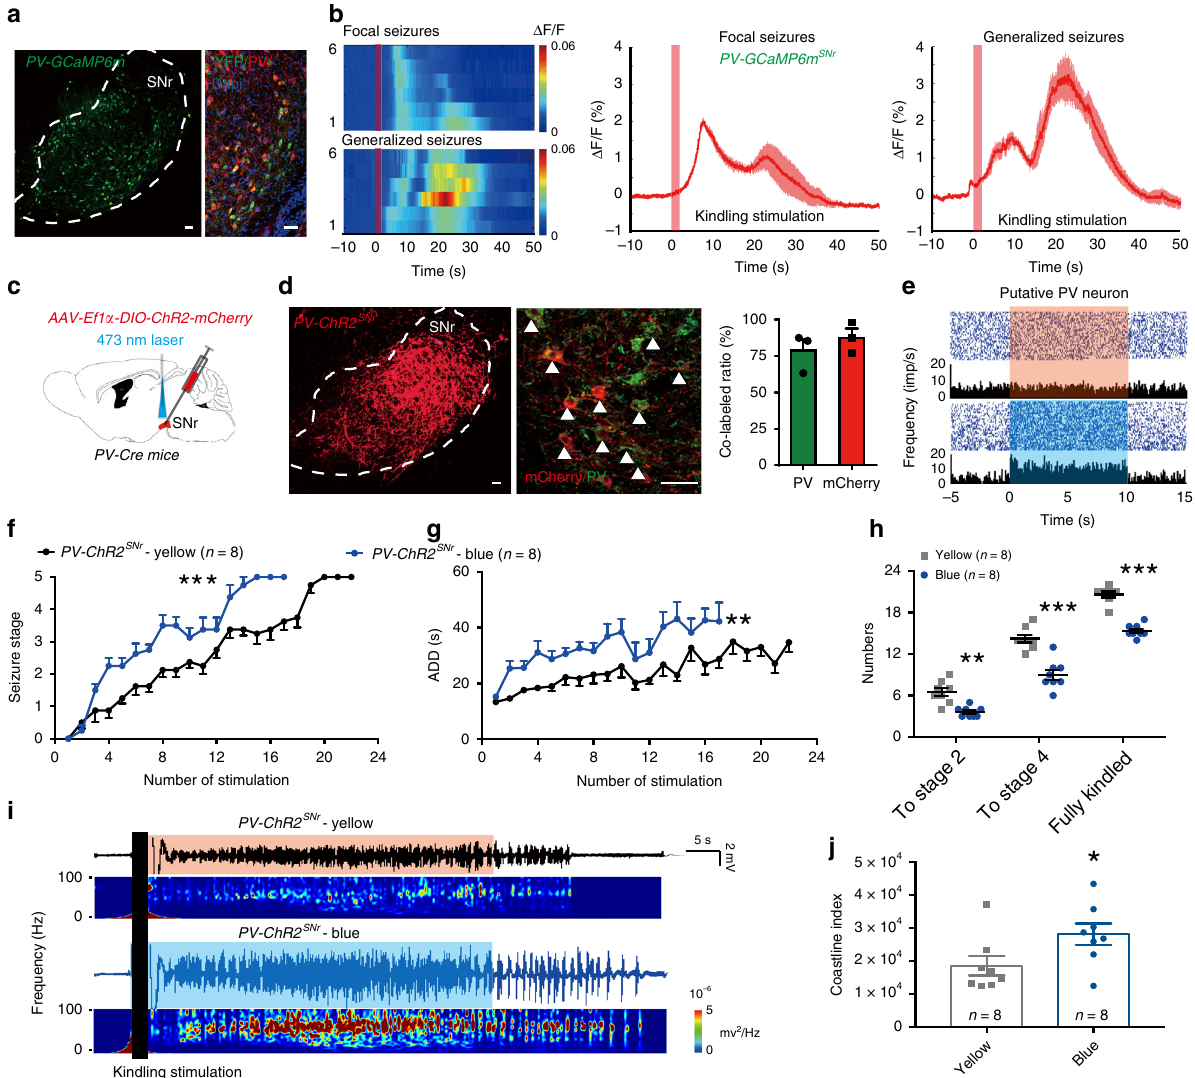
Fig. 1 Optogenetic activation of SNr PV neurons ampli fi es kindling progression in hippocampal kindling model. a Representative images of the SNr from a PV-GCaMP6m SNr mouse, showing the overlap of GCaMP6m- eYFP and PV-positive neurons. Scale bar, 50 μ m. b Fiber photometry of SNr PV neural dynamics during hippocampal kindling seizures in PV-GCaMP6m SNr mice. Left, heatmap illustration of calcium signals aligned to the initiation of kindling stimulation. Each row represents the typical calcium signal of each mouse during focal seizures and generalized seizures, and a total of six mice are illustrated. Color scale indicates Δ F / F and warmer colors indicated higher fl uorescence signal. Right, peri-event plots of the average calcium signals corresponding to the heatmaps. Thick lines indicated mean and shaded areas indicated SEM. The red rectangles represent kindling stimulation. c Scheme of experiment for viral injection and photostimulation in PV-ChR2 SNr mice. d Representative images of the SNr from a PV-ChR2 SNr mouse, showing the overlap in expression of ChR2-mCherry (red) and PV-positive neurons (green). Scale bar, 50 μ m. Right, quanti fi cation of the percentage of ChR2-mCherry neurons that co-expressed PV neurons from three PV-ChR2 SNr mice (repeated three times per mouse). e Representative peri-event raster histograms showing the fi ring rate of the same SNr PV neuron in response to blue-light and yellow-light stimulation. f – h Effects of optogenetic activation of SNr PV neurons on the development of seizure stage ( f ), afterdischarge duration (ADD, g ), and number of stimulations needed to reach each seizure stage ( h ) in the hippocampal kindling model. Align-and-rank data for a nonparametric ANOVA was used for f , general linear model with repeated measures was used for g , and Mann – Whitney U -test was used for h ; ** P < 0.01, *** P < 0.001 compared with yellow-light control. i , j Representative EEGs, corresponding EEG spectra power ( i ), and the quanti fi cation of EEG coastline index ( j ) recorded from the CA3 during the fully kindled state. The black rectangle represents kindling stimulation. Unpaired t -test was used for j ; * P < 0.05, compared with yellow-light control. The number of mice used in each group is indicated in the fi gure. Data are presented as means ± SEM. Source data are provided as a Source Data fi le.